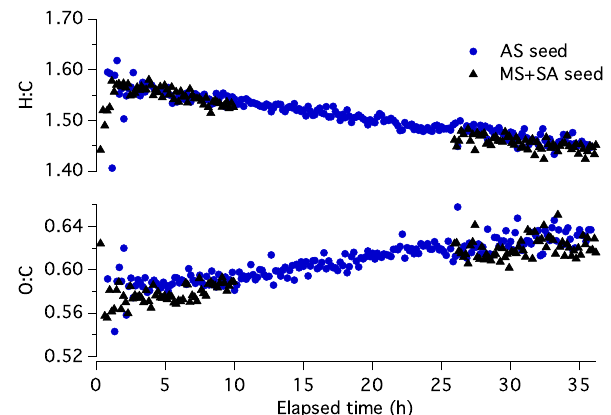
Fig. 14. Elemental ratios of m -xylene aerosol condensed onto neu- tral (AS) and acidic (MS+SA) seed